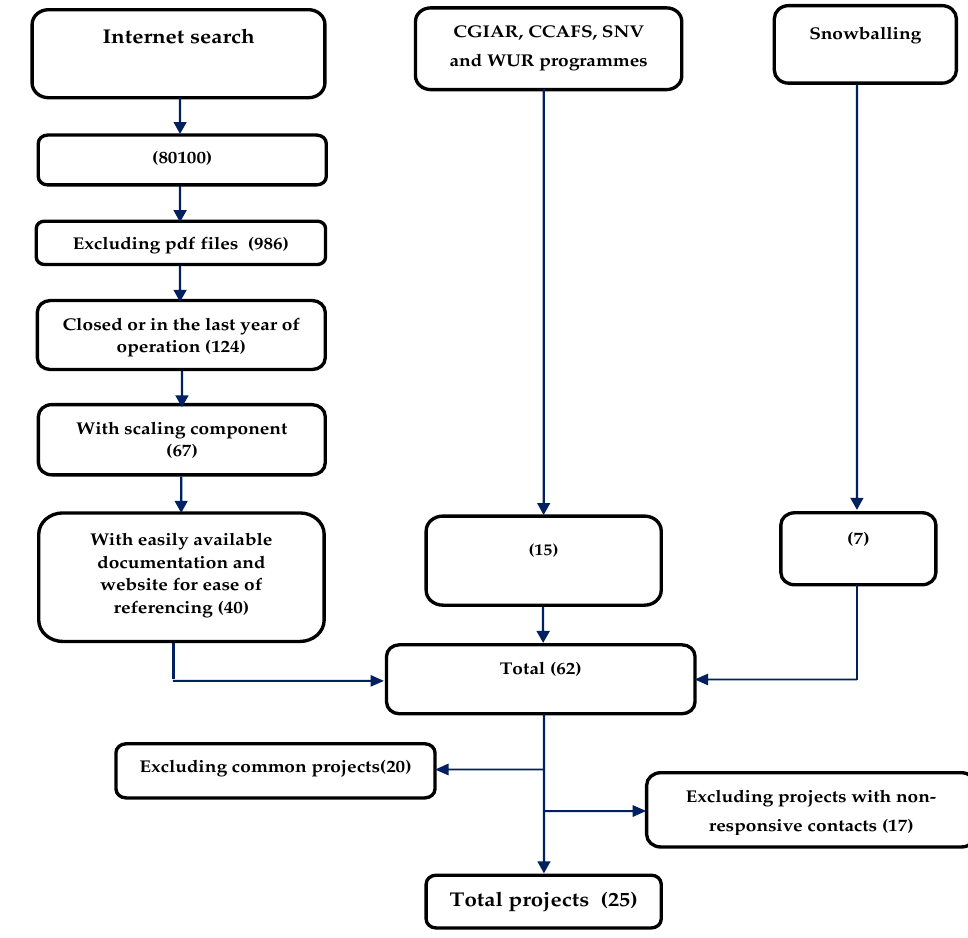
Figure 1. Case identification process.